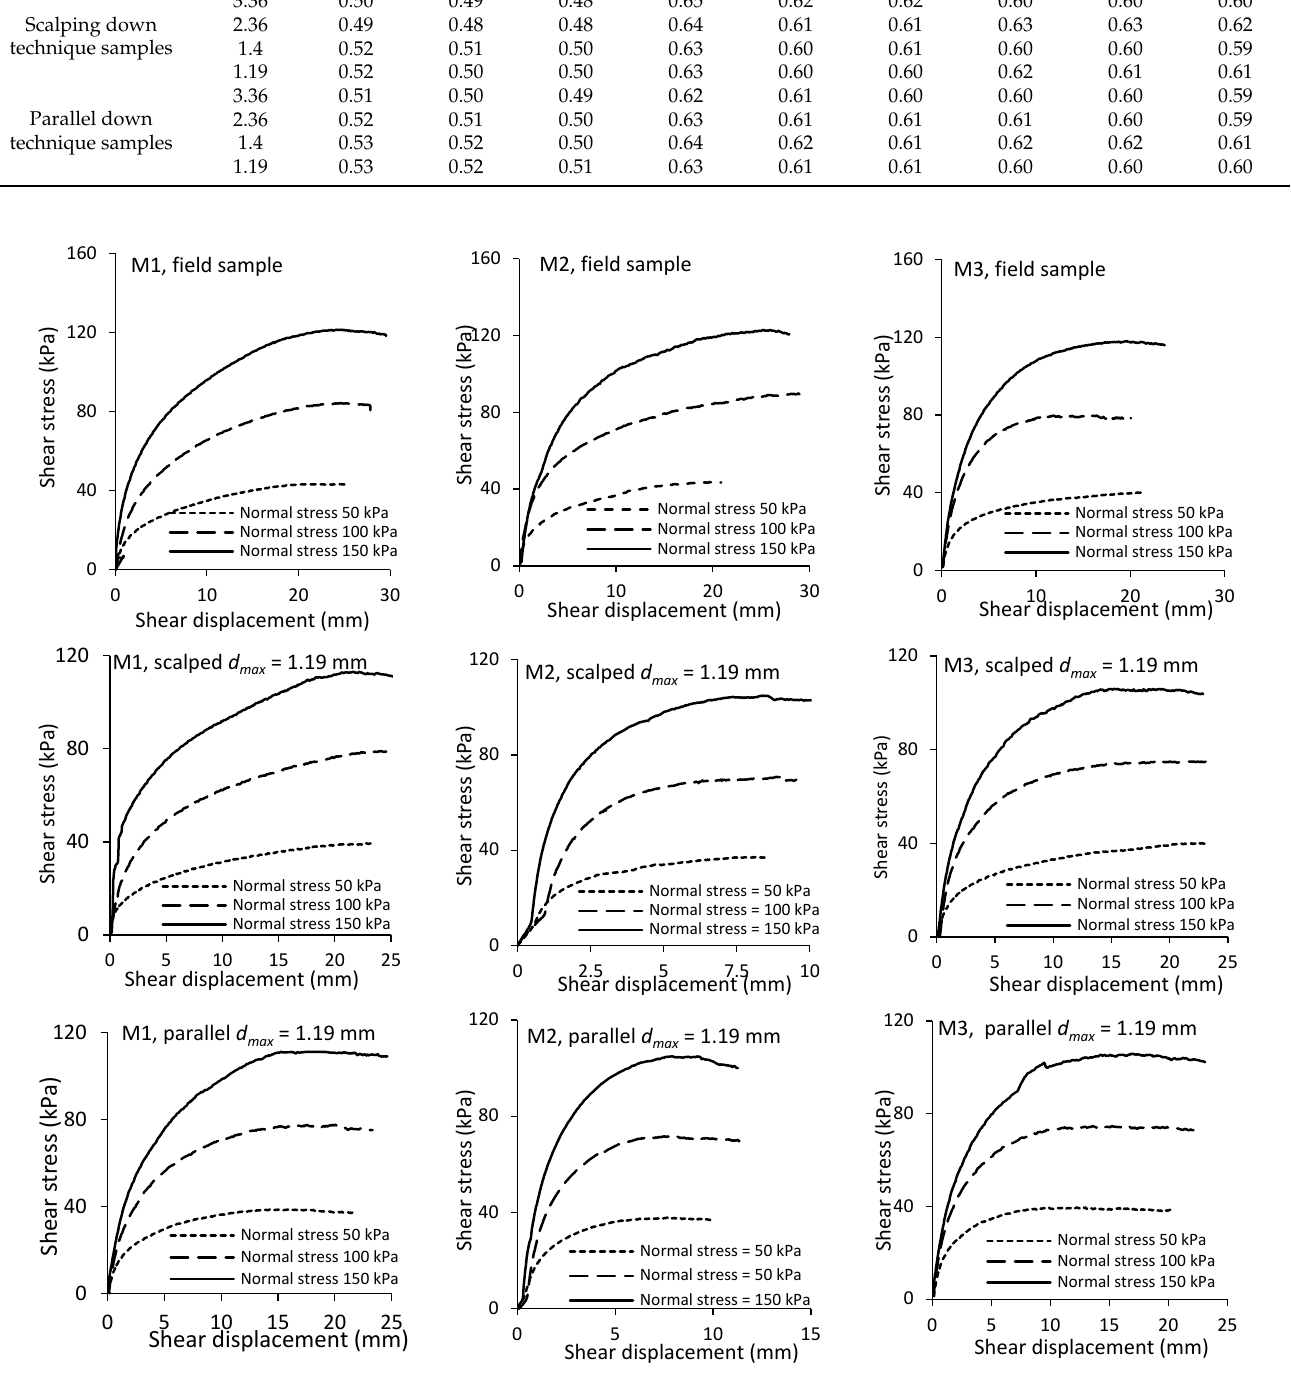
Figure 5. Shear stress vs. shear displacement curves obtained with the large shear box on field samples and scaled down samples with d max value of 1.19 mm for M1 (graphs on left column), M2 (graphs in the center column) and M3 (graphs on right